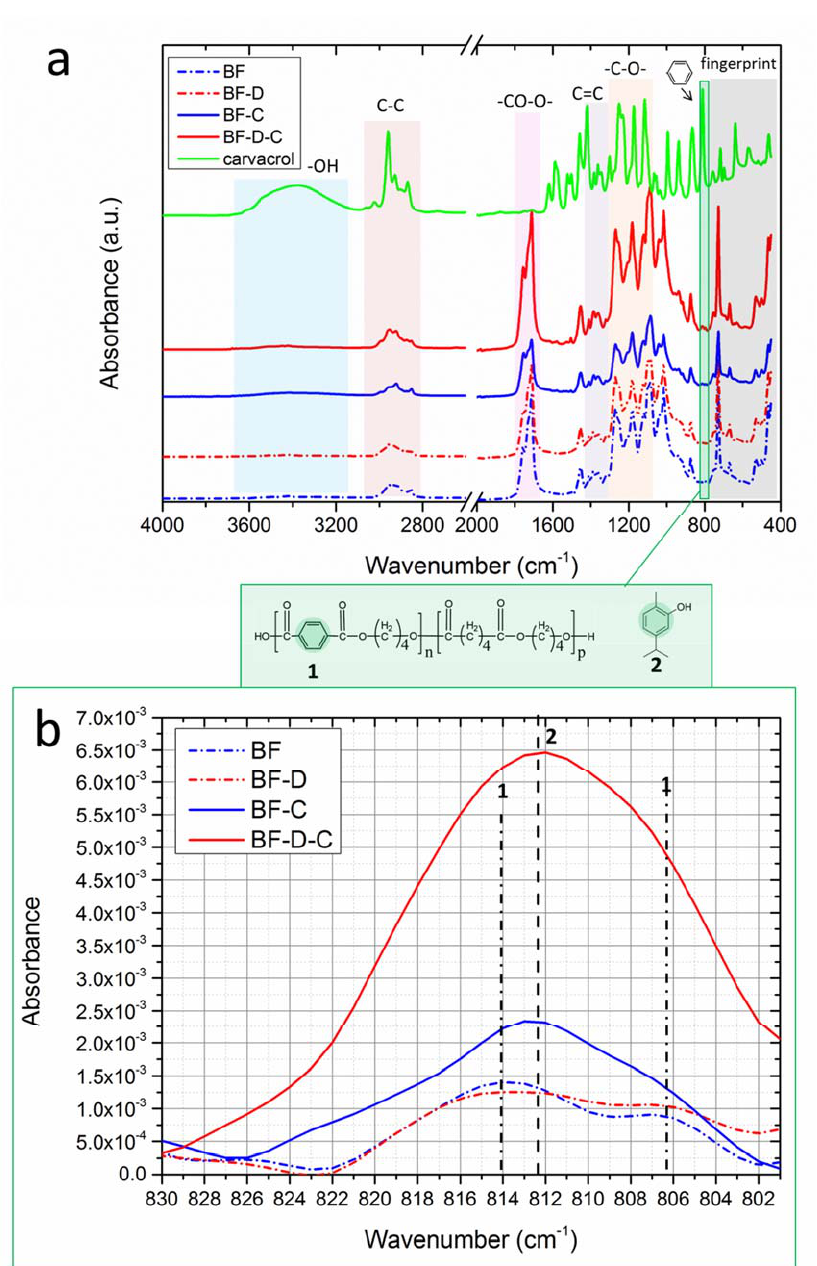
Figure 2. ( a ) FTIR / ATR spectra collected in the range 4000–450 cm − 1 ; ( b ) close-up of the spectral range 830–800 cm − 1 for the detection of carvacrol.